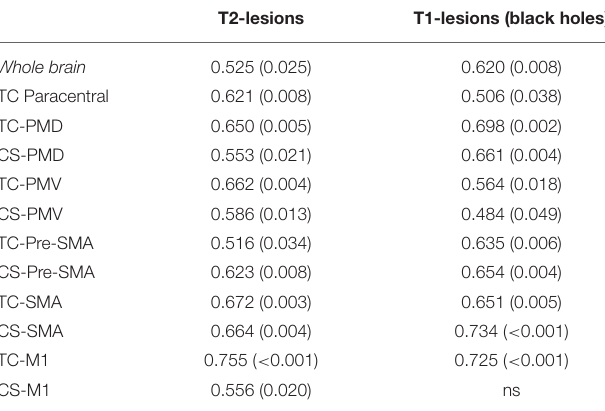
TABLE 4 | Significant correlations between tract-specific lesion volume and